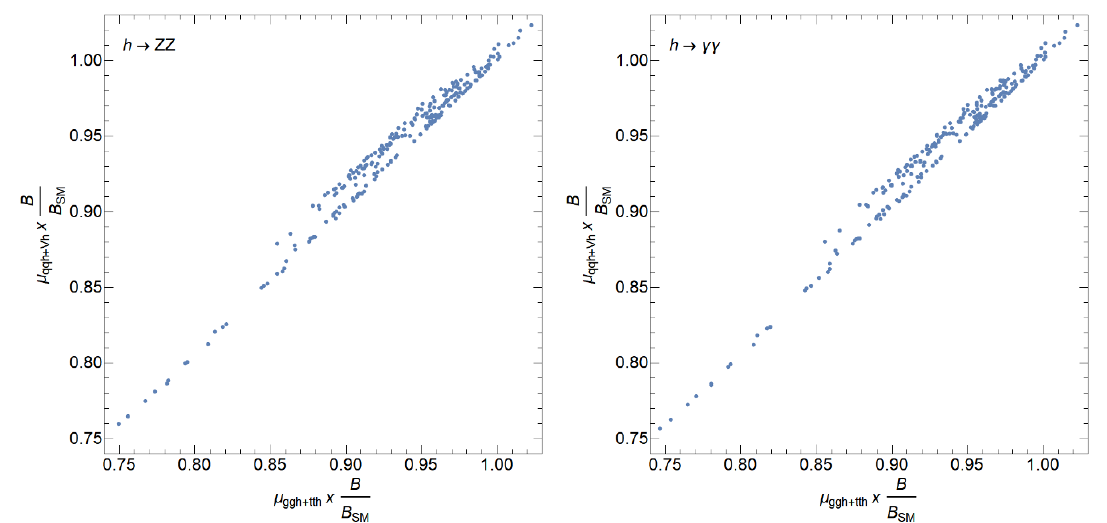
Figure 7 . Left panel: rates in the h ! ZZ decay channel separated according to production mode: gluon fusion (+ tth ) versus VBF (+ hW=Z ). Right panel: same for the h ! (cid:13)(cid:13) . The points correspond to the